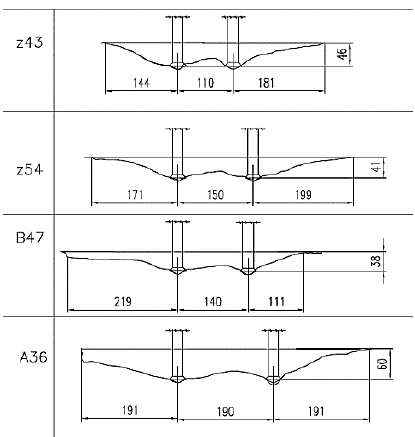
embedment depth.